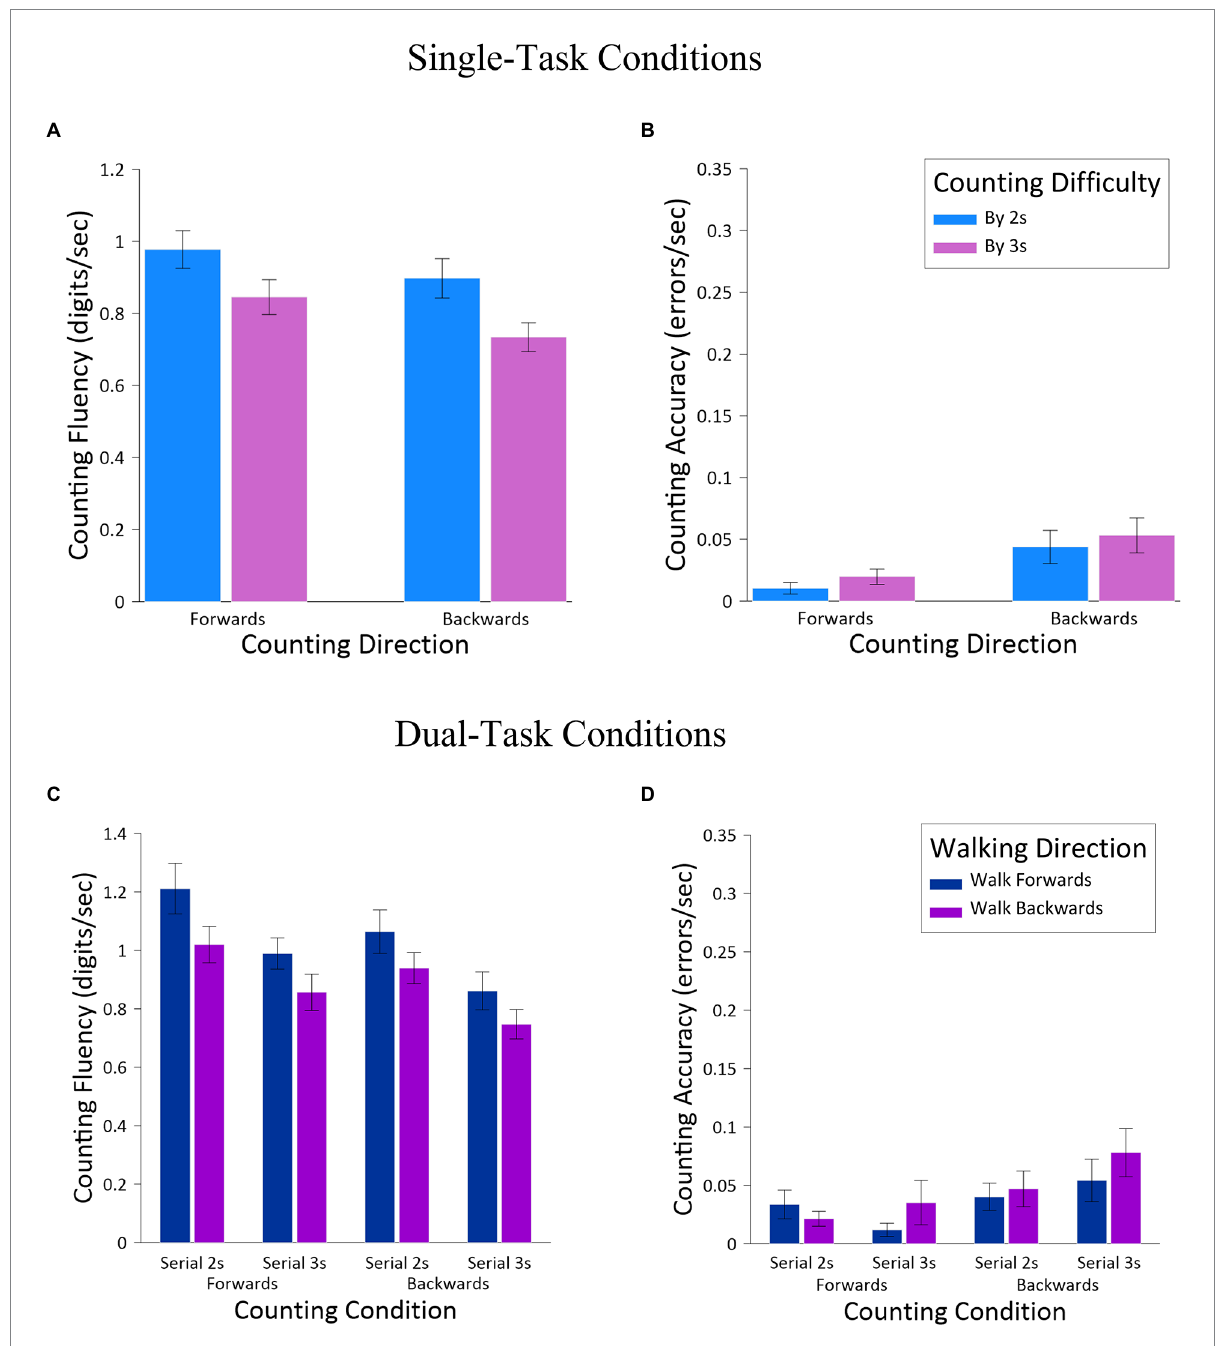
FIGURE 3 Single-task cognitive measures [counting fluency ( A ) and counting accuracy ( B )] and dual-task measures [counting fluency ( C ) and counting accuracy ( D )], as a function Walking Direction, Counting Direction , and Counting Difficulty